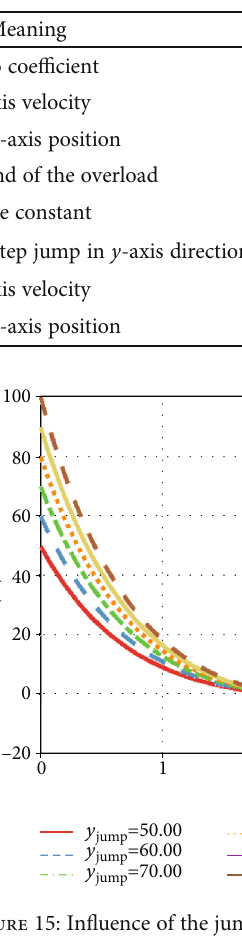
Table 2: Initial simulation parameter setting.